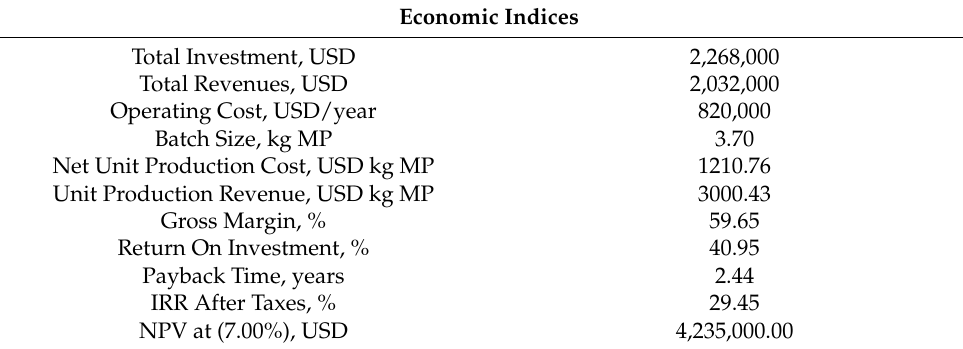
Table 6. Economic evaluation: Scenario 3—3 USD/g—batch throughput 3.7